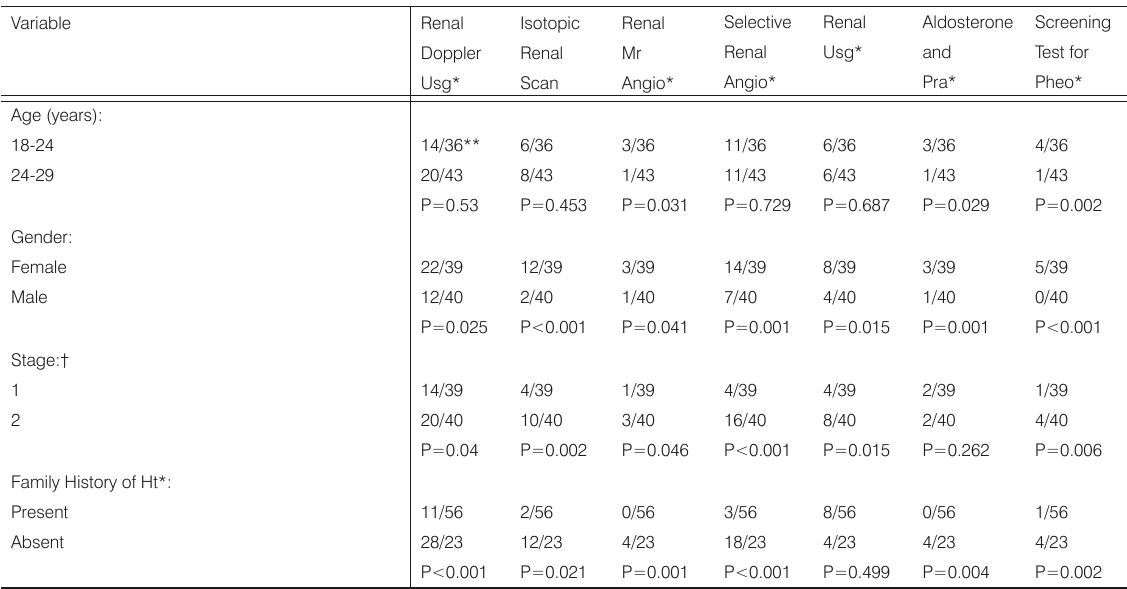
Table 1. Distribution of diagnostic tests according to clinical variables (age, gender, stage of hypertension according to JNC-7* and presence of family history of hypertension) among patients with primary hypertension.